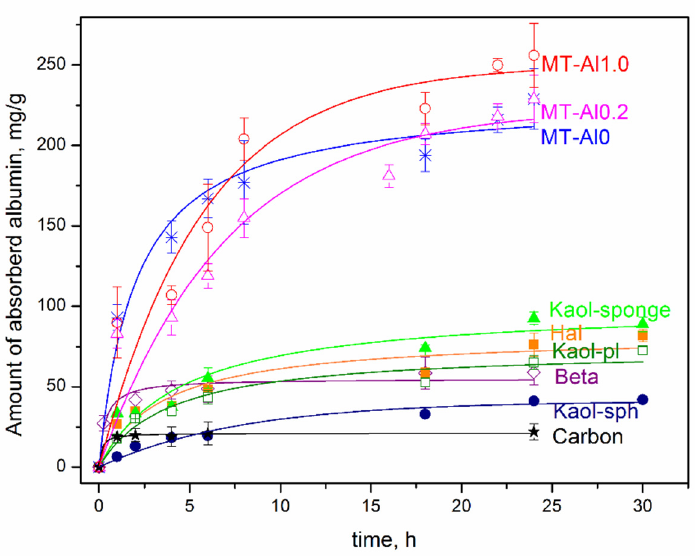
Figure 5. Kinetic curve of albumin by the aluminosilicate samples and activated carbon. Samples are designated in accordance with the designations presented in Table 1.